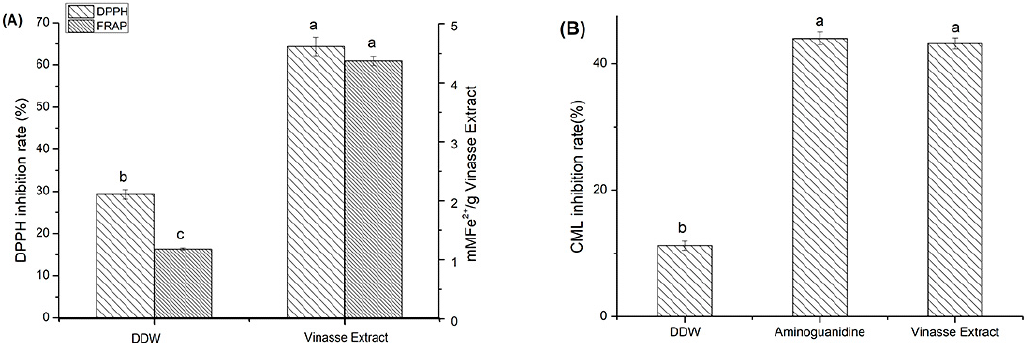
Figure 2. ( A ) The antioxidant capacities of the vinasse extract as measured by DPPH and ferric ion reducing antioxidant power (FRAP). ( B ) The inhibitory rate of CML formation by vinasse extract, double distilled water (DDW), and aminoguanidine (values are presented in mean ± standard deviation ( n = 3)). Different superscript letters (a–c) in the coordinate axis denotes significant differences at p < 0.001 (* p < 0.05).